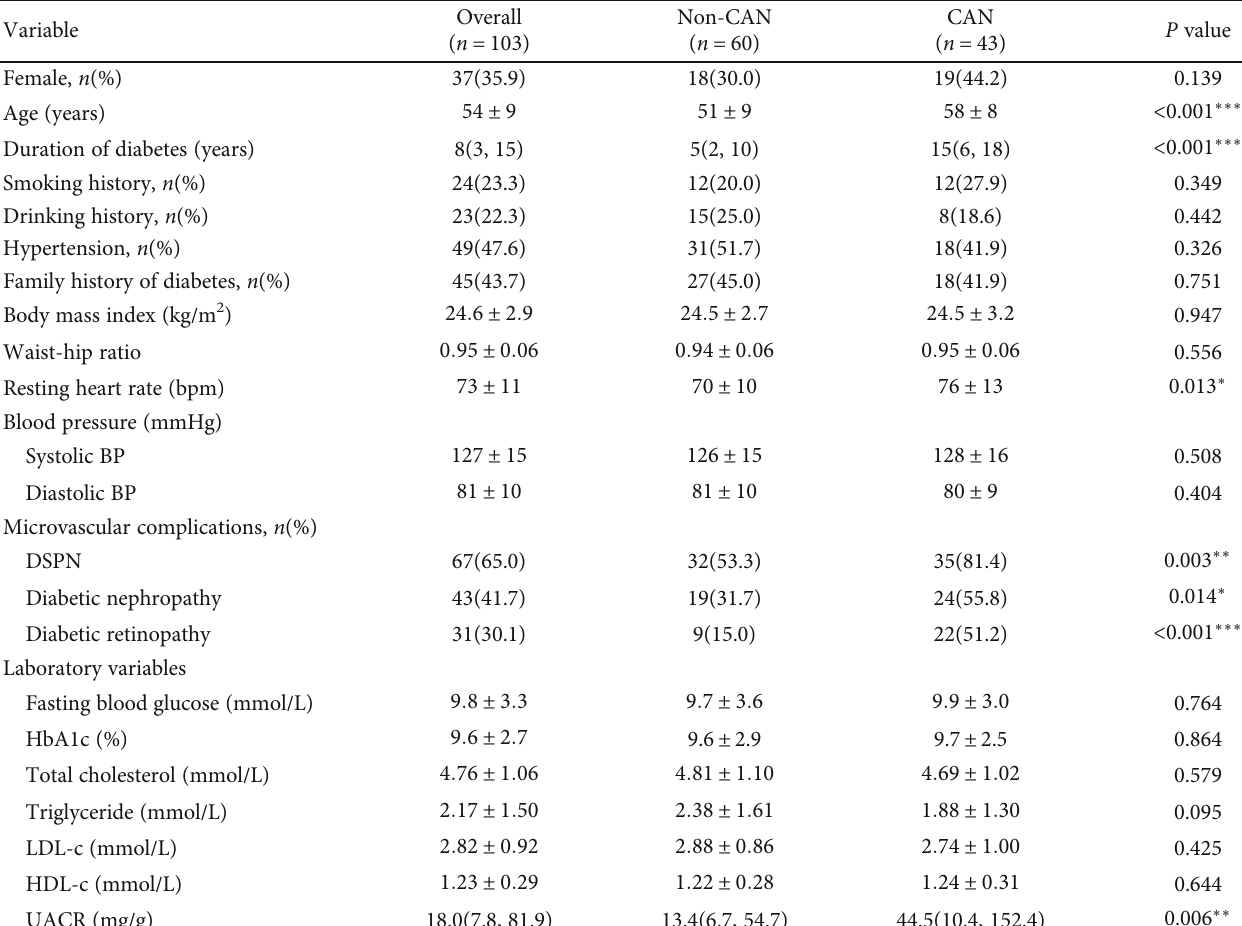
Table 1: Clinical characteristics of the study